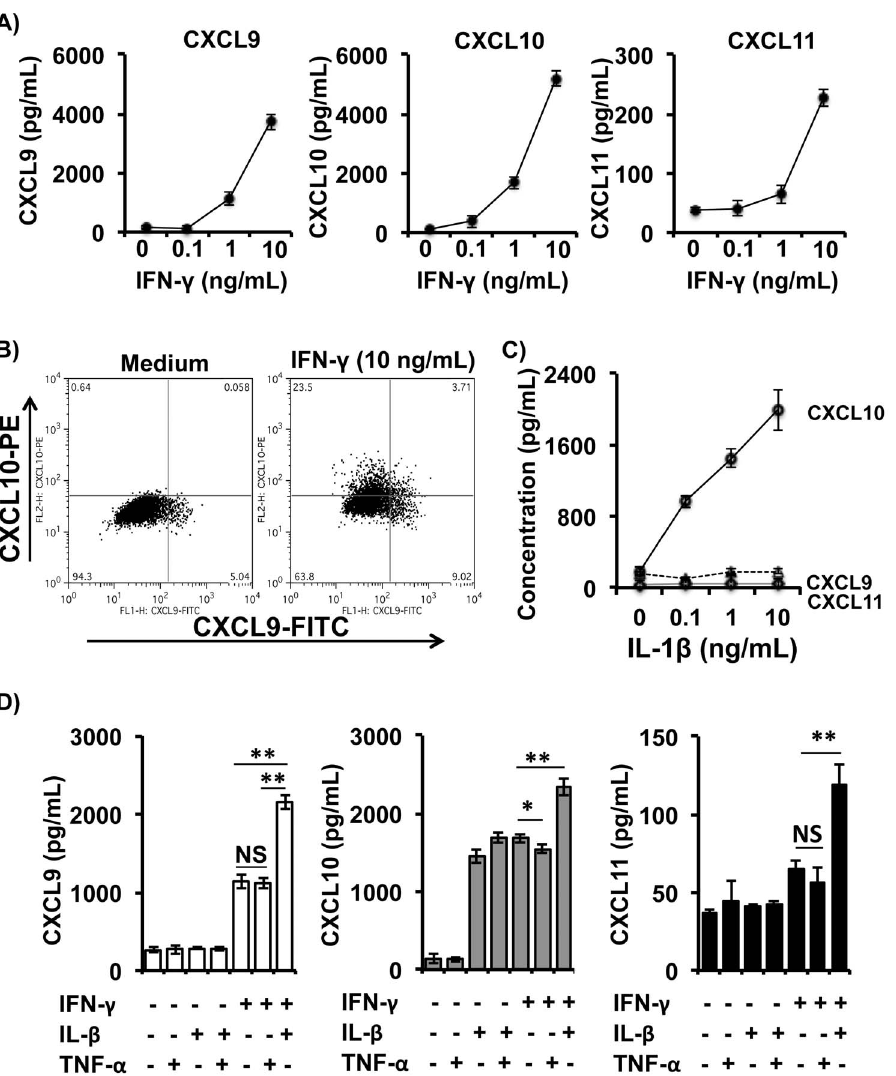
Figure 3. Human hepatocytes produce CXCR3-associated chemokines in response to various stimulants. Huh7.5.1 cells in 24-well plates were treated or untreated with IFN- c , IL-1 b , TNF- a or their combinations at various concentrations for 24 h at 37 u C. Cell-free supernatant and cells were subjected to measurement of expression of CXCL9, CXCL10, and CLCL11 using ELISA and FACS, respectively. A) IFN- c induced Huh7.5.1 cells to produce CXCL9, CXCL10, and CXCL11 in a dose-dependent manner. B) FACS analysis of intracellular CXCL9, CXCL10, and CXCL11 levels in Huh7.5.1 cells in response to IFN- c stimulation at 10 ng/mL. C) CXCL10, but not CXCL9 or CXCL11, was produced by Huh7.5.1 cells in response to IL-1 b treatment in a dose-dependent manner. D) IL-1 b , but not TNF- a , enhanced IFN- c activity in induction of CXCR-associated chemokines by Huh7.5.1 cells. Error bars represent mean 6 SD of values from triple wells in each dose. Note that different Y-axis values among CXCL9, CXCL10 and CXCL11 are used. NS, not significant; p $ 0.05; **, p , 0.01; and *, p ,